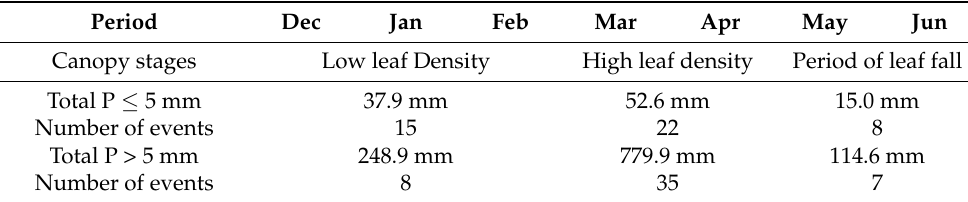
Table 2. Summary of the three stages of canopy development as a function of the rainfall depth and canopy density. Period Dec Jan Feb Mar Apr May Jun Canopy stages Low leaf Density High leaf density Period of leaf fall Total P ≤ 5 mm 37.9 mm 52.6 mm 15.0 mm Number of events 15 22 8 Total P > 5 mm 248.9 mm 779.9 mm 114.6 mm Number of